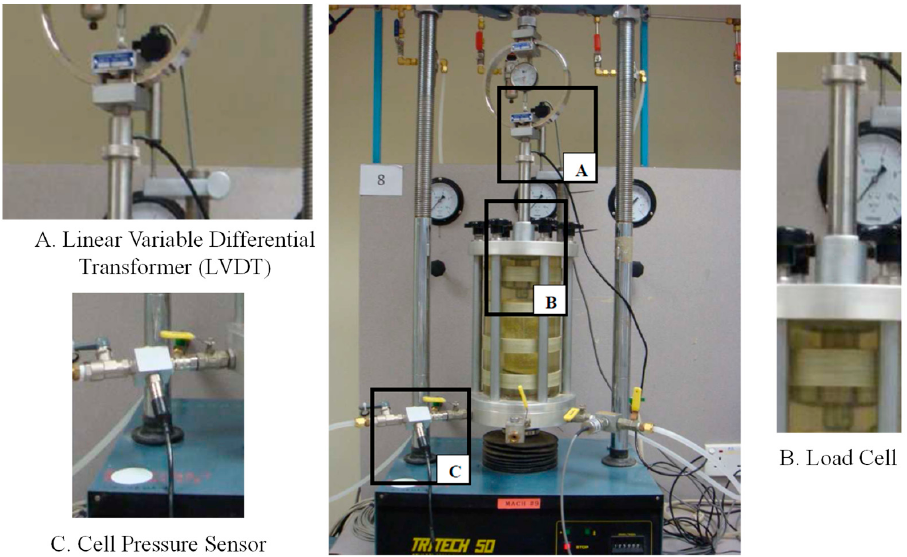
Figure 5. Unconsolidated and undrained (UU) triaxial test setup in laboratory.